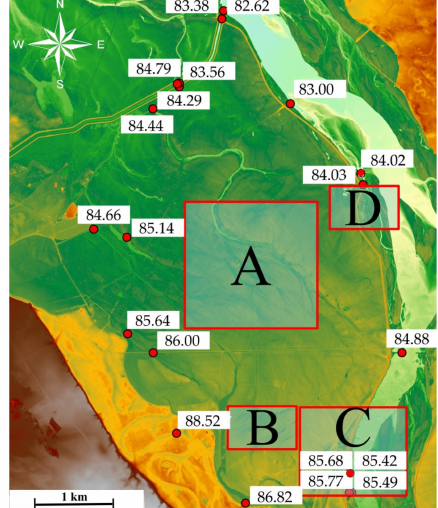
Figure 5. Location of polygons characteristic for the distinguished morphodynamic types of the analyzed floodplain area: A represents the zone of the transformed floodplain, B , C , D represent the areas where crevasse splays and crevasses were identified, red dots mark the points of water level measurements, numbers mean the water level measured in watercourses and rivers defining the boundaries of the modeling